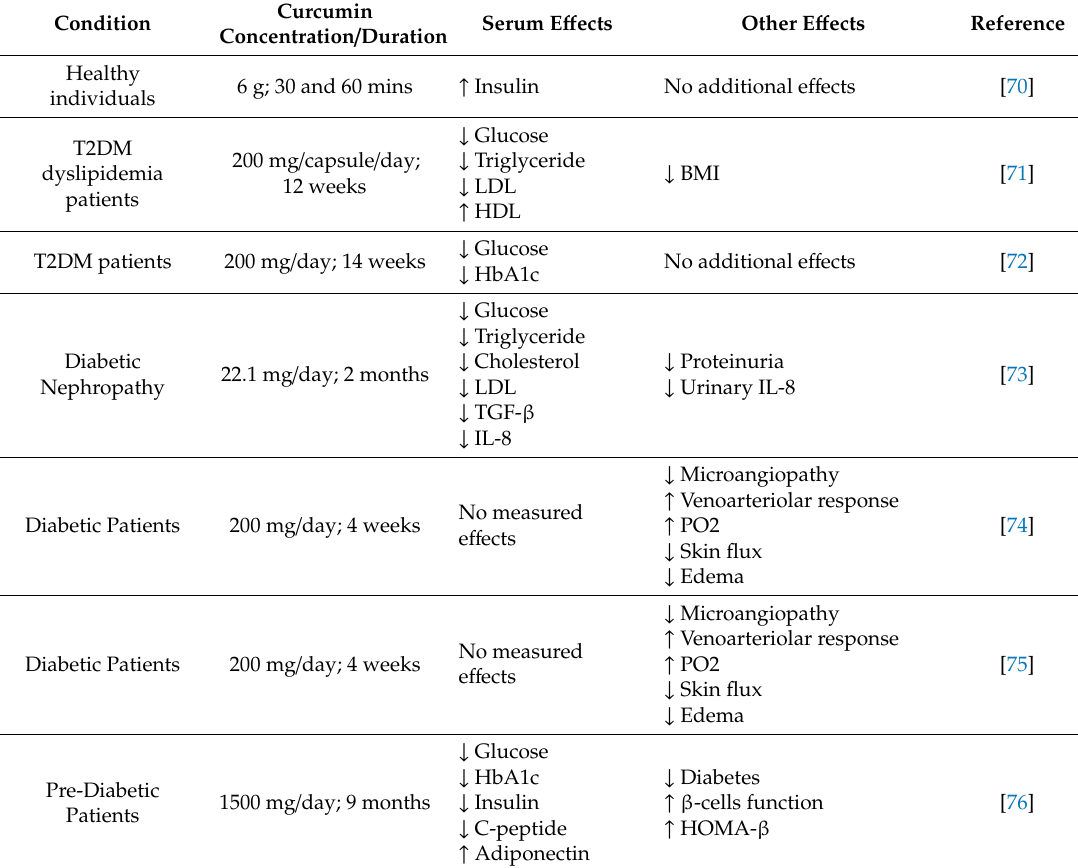
Table 5. E ff ects of curcumin: Human